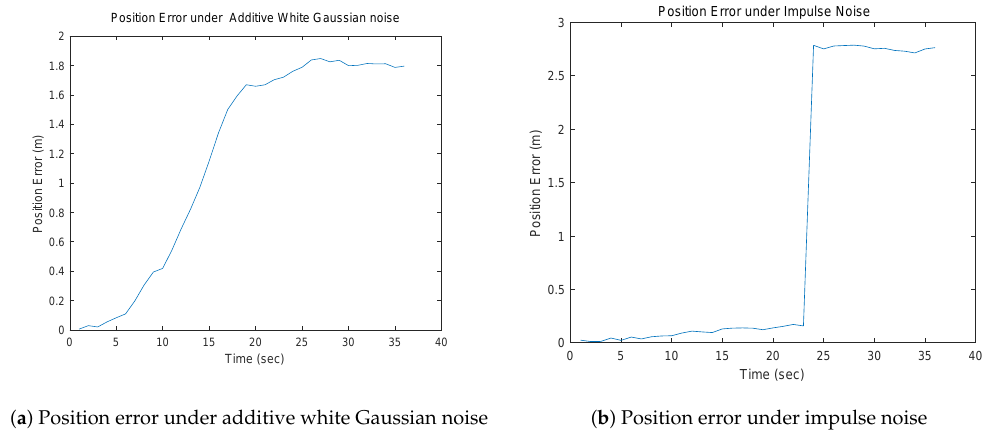
Figure 3. Position errors under additive white Gaussian noise and impulse